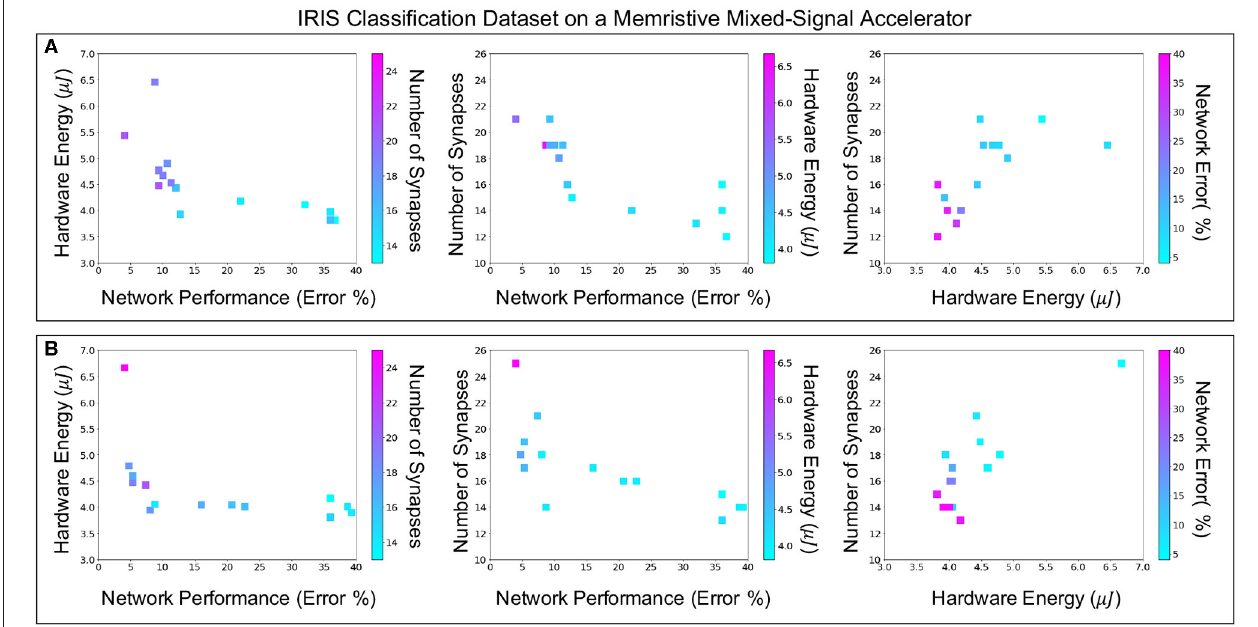
FIGURE 7 | Comparing three-dimensional H-PABO results, pairwise for (A) case study six with search space size 1,458, (B) case study eight with search space size 35,640.